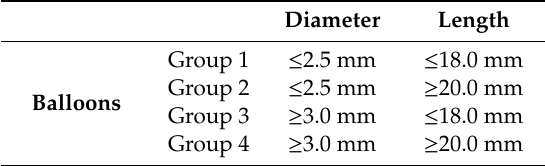
Table 1. Groups of balloons and